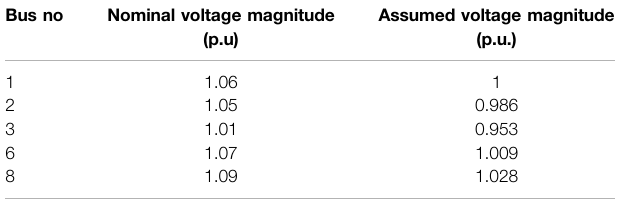
TABLE 1 | IEEE 14 bus